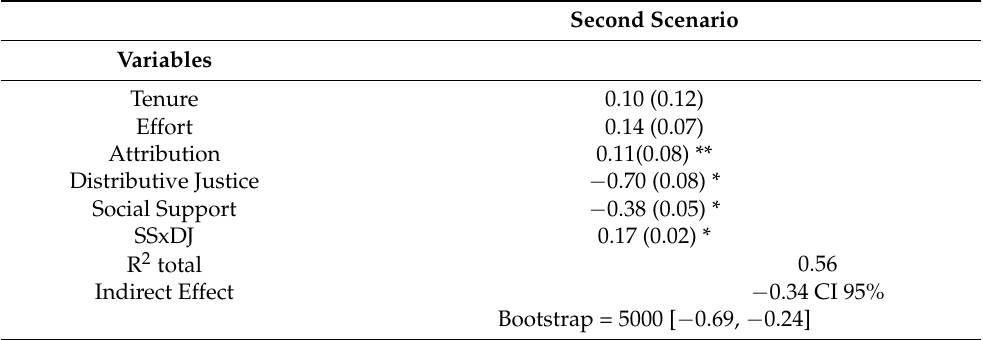
Table 5. SME model of social support as moderator of indirect effect of responsibility on expected emotional exhaustion with distributive justice as mediator ( N = 227).